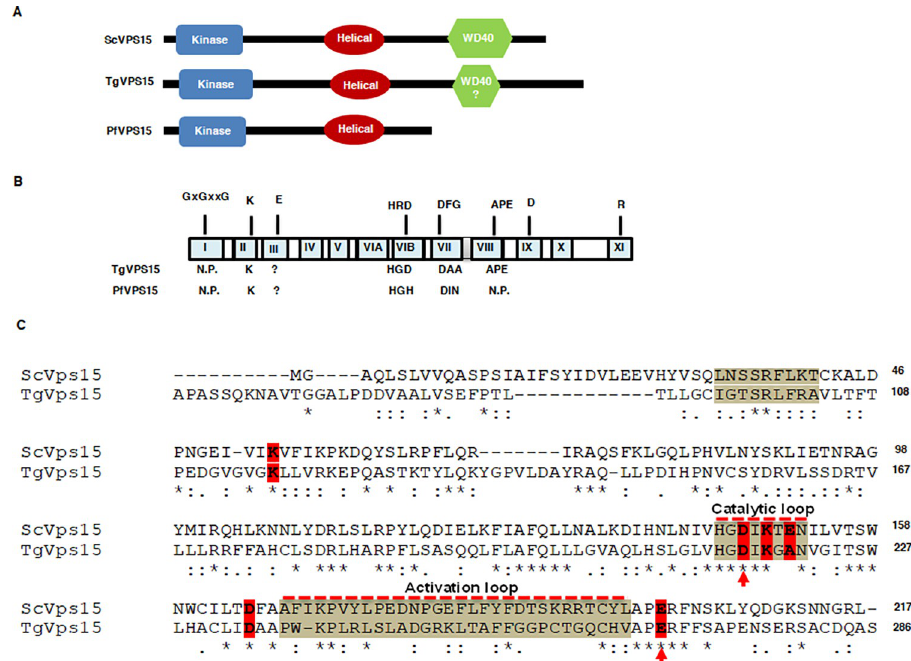
Fig 1. A VPS15 orthologue in P . falciparum and Toxoplasma gondii . A. Domain organization of Pf/TgVPS15 revealed that TgVPS15 contains a kinase like domain (KD) at the N-terminus followed by helical HEAT repeats, which are connected by long linkers. WD40 could not be predicted with certainty as only weak sequence similarity was found to WD40 repeats in the case of TgVPS15 whereas PfVPS15 does not contain the C-terminal WD40 domain. B. Schematic illustrating the subdomains of canonical protein kinases and key putative residues involved in catalysis are indicated on the top and corresponding residues in Tg/PfVPS15 are indicated below. N.P.—not present. C. CLUSTALW alignment of the kinase domains of ScVPS15 with TgVPS15. Some of the key motifs and subdomains are indicated and putative residues possibly involved in kinase function are highlighted. D216 and E268, which were mutated in subsequent studies, are indicated by an